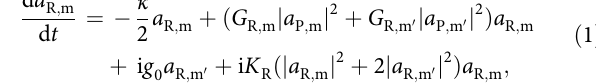
Note 1). If not indicated otherwise, we will assume to work with an ideal medium, where G ward and backward stimulated Raman scattering.